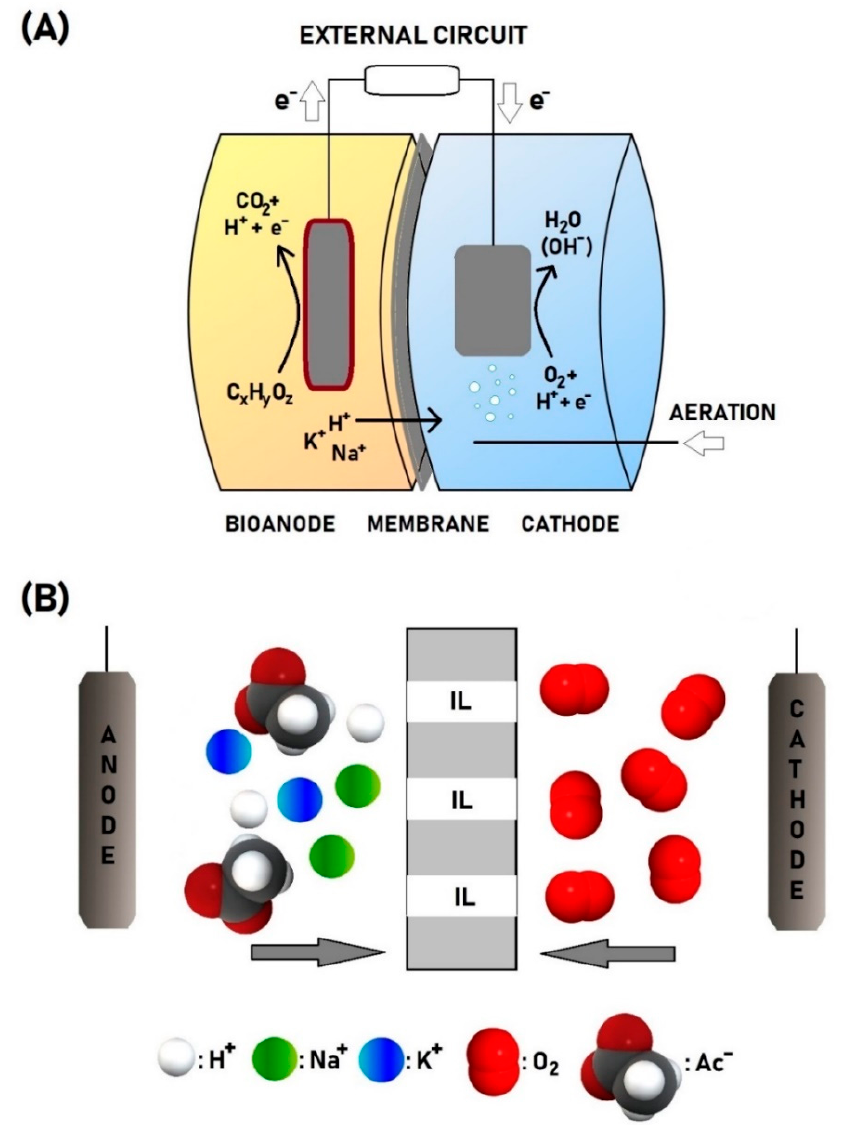
Figure 1. The scheme of a double-chamber microbial fuel cell (MFC) structure and working principles ( A ), and the main components transported through the ionic liquid (IL)-containing membrane ( B ).